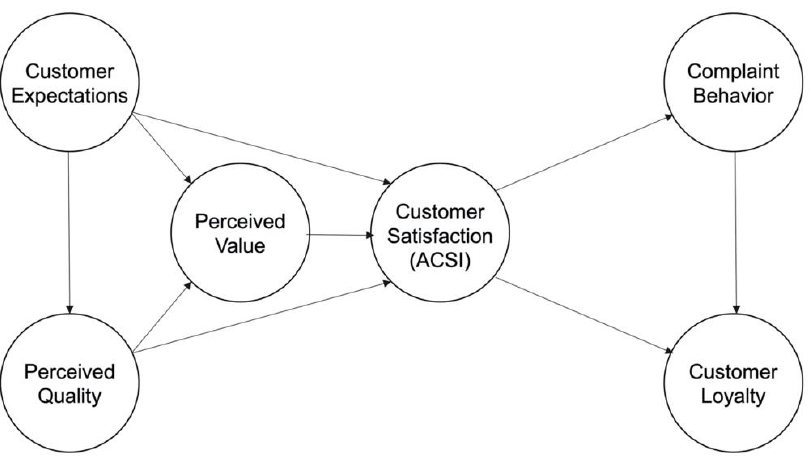
Figure 1. The American Customer Satisfaction Index (ACSI) model. (Source: [49]).